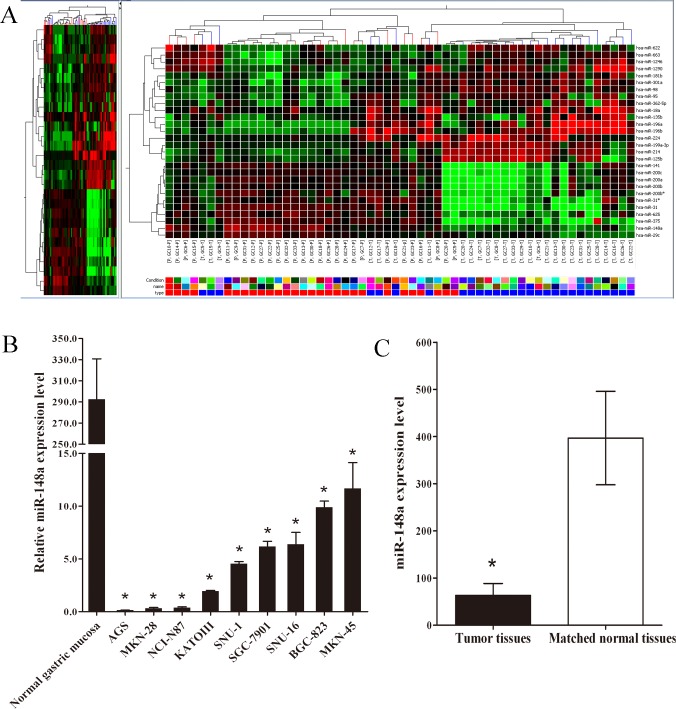
MiR-148a expression was down-regulated in gastric cancer tissues and gastric cancer cell lines compared with the corresponding controls.(A) MiRNA microarray assay was carried out using 28 surgical specimens of gastric cancer tissues. (B) QRT-PCR was carried out using nine gastric cancer cell lines and one pooled normal gastric mucosa tissue. The mean and standard deviation of miR-148a expression levels are shown. The data represent triplicate measurements from single RNA samples (*, P < 0.05, compared with pooled normal gastric mucosa). (C) QRT-PCR was carried out using 41 surgical specimens of gastric cancer tissues (black bar) and matched normal tissues (white bar). The mean and standard deviation of miR-148a expression levels are shown. The data represent triplicate measurements from single RNA samples (*, P < 0.05).